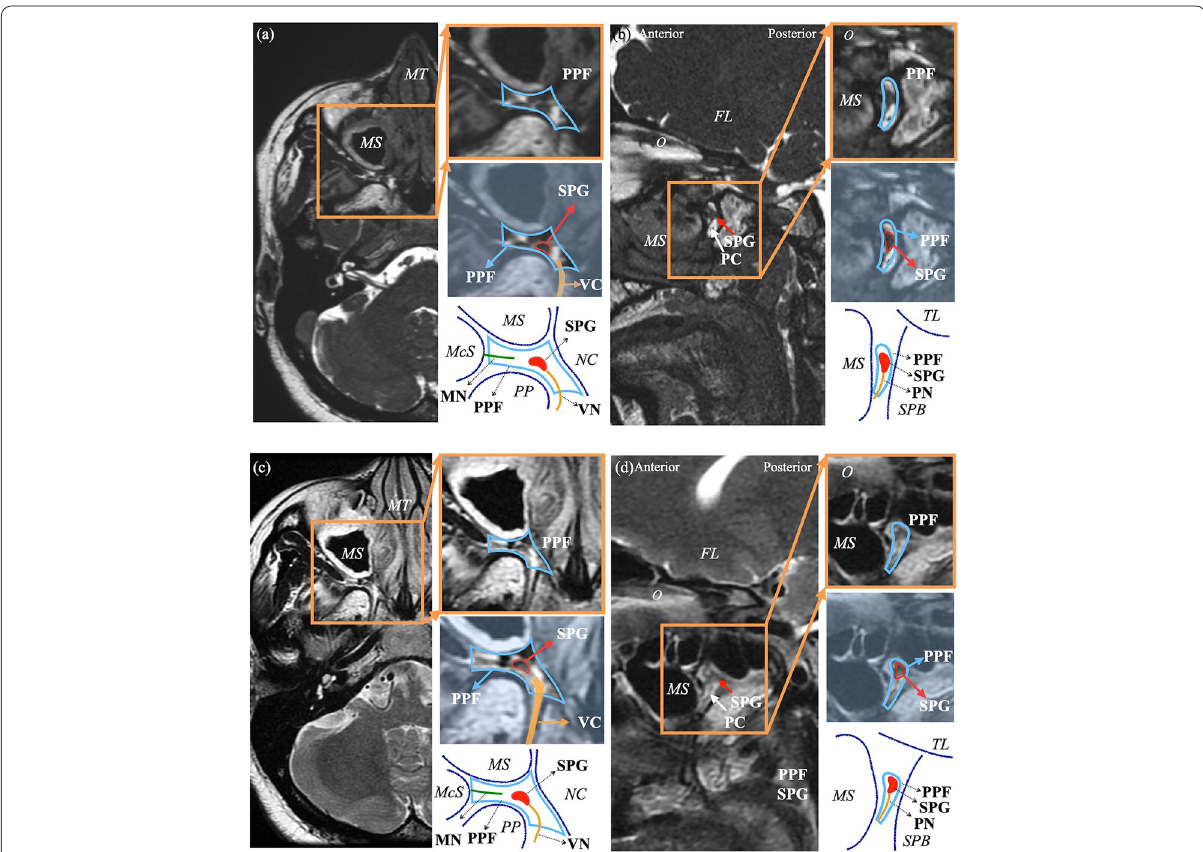
Fig. 2 Visualization and measurement of the SPG. Axial ( a ) and sagittal ( b ) FIESTA MRI, axial ( c ) and sagittal ( d ) T2‑weighted MRI depicting the sphenopalatine ganglion (SPG) (the red arrow is positioned in the center of the SPG, blue arrow is positioned at the pterygopalatine fossa [PPF]). The SPG has a crescent shape and intermediate signal intensity. The image surrounded by the orange rectangle is the ‘zoomed‑in’ image. The light blue polygon depicts the border of the PPF. The oval red line is the border of the SPG. The dark blue line depicts the adjacent structure of PPF. FL cerebral frontal lobe, McS masticator space, MN maxillary nerve, MS maxillary sinus, MT middle nasal turbinate, NC nasal cavity, O orbit, PC palatine canal, PN palatine nerve, PPF pterygopalatine fossa, PP pterygoid process, SPB sphenoid bone, TL temporal lobe, VC vidian canal, VN vidian